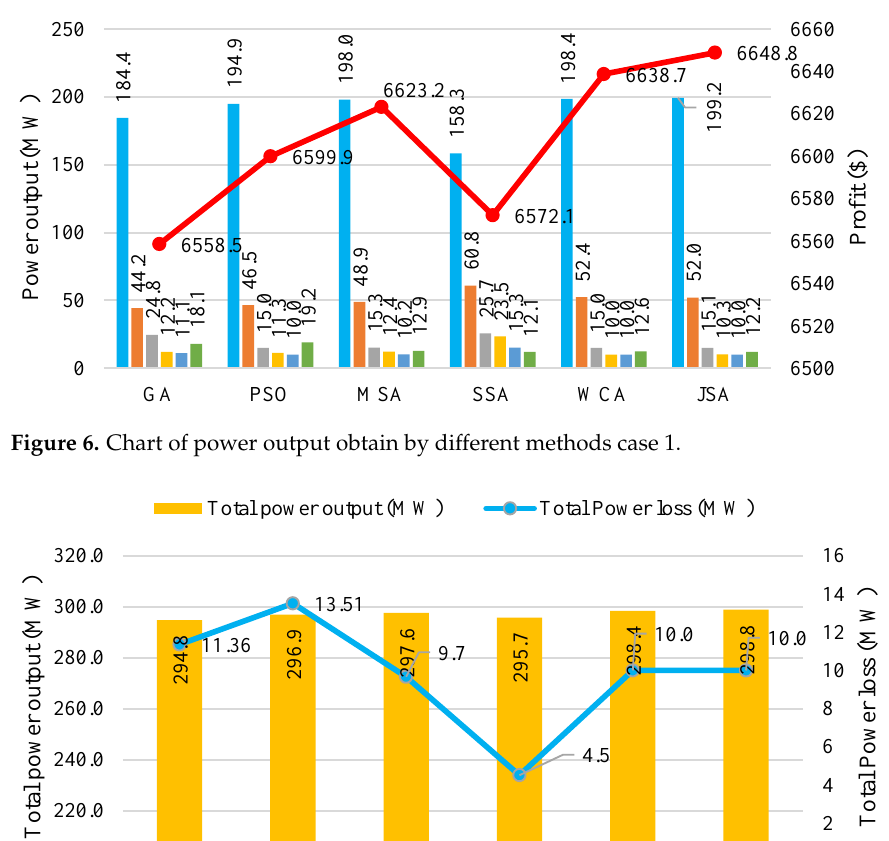
Figure 6. Chart of power output obtain by different methods case 1.